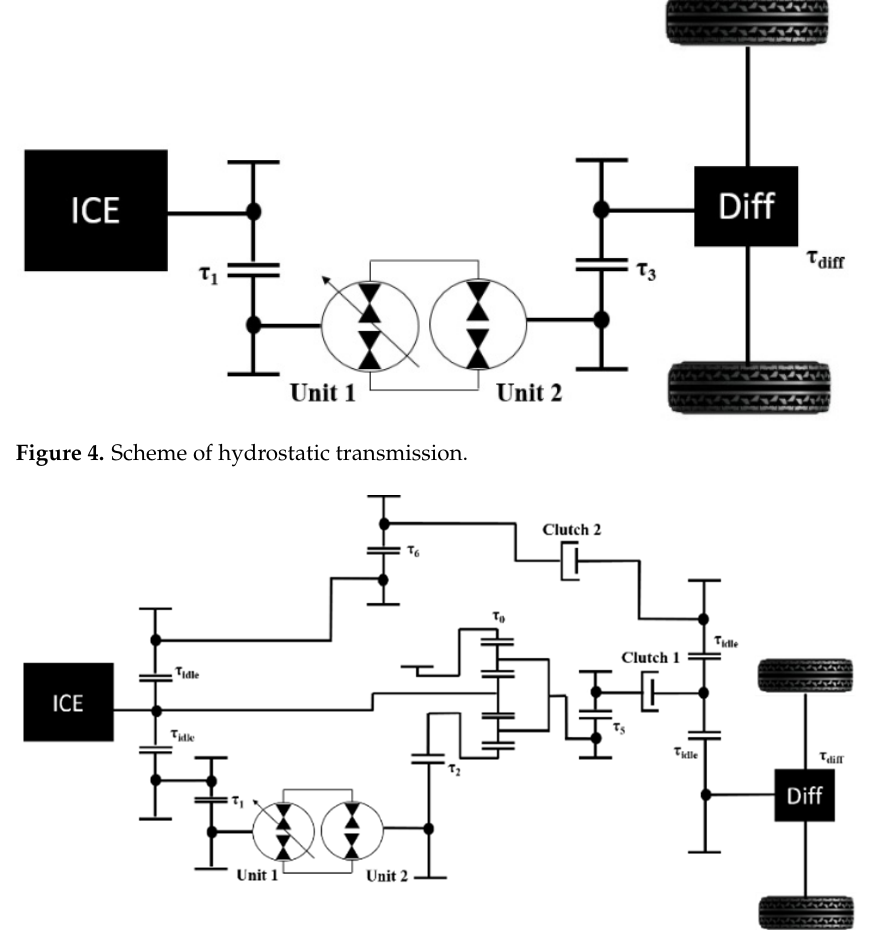
Figure 5. Scheme of CVT input-coupled transmission with lockup clutch.